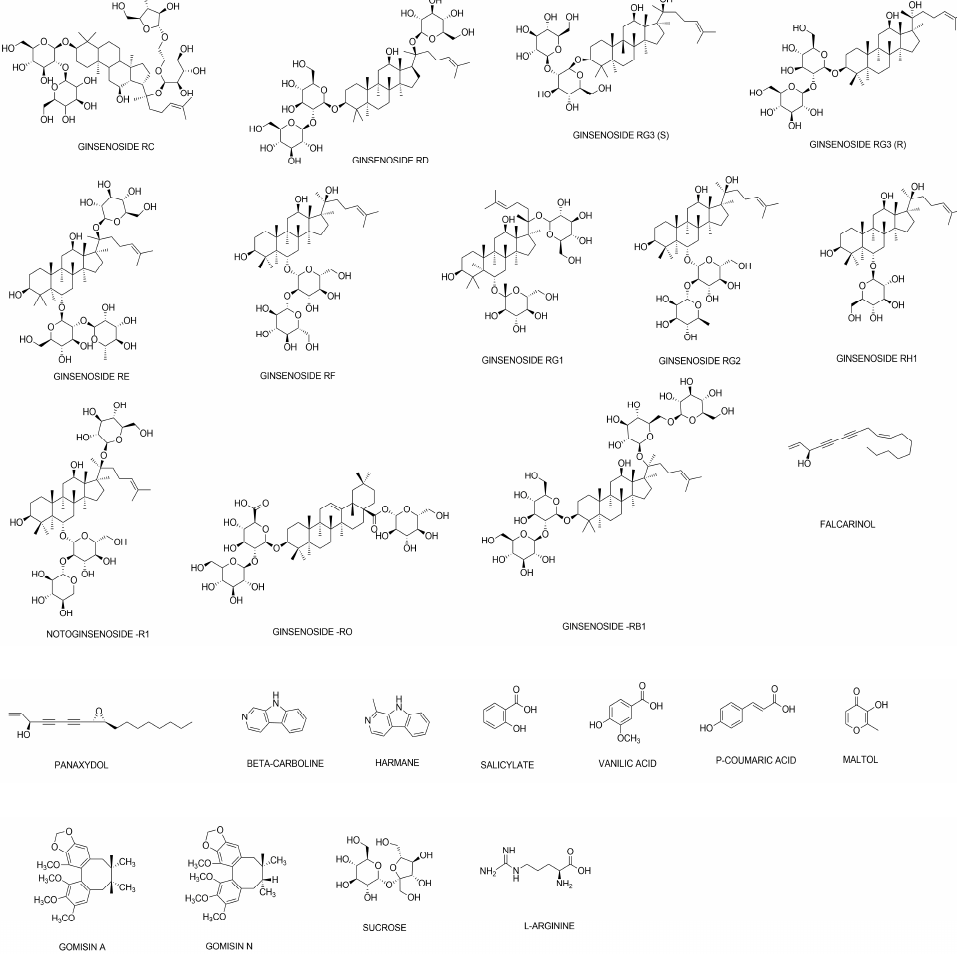
Figure 1. Structural formulae of components in red ginseng with their target genes.